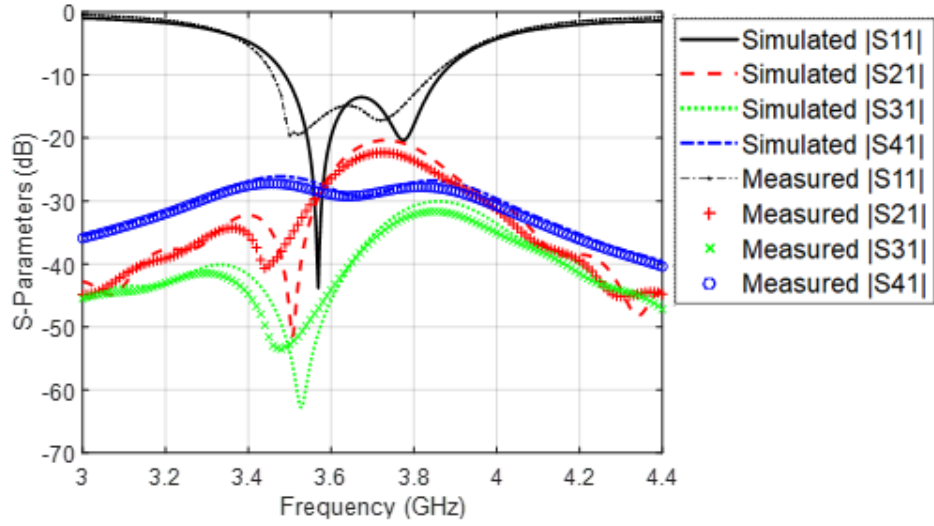
Figure 12. Simulated and measured s-parameters of the proposed MIMO structure.